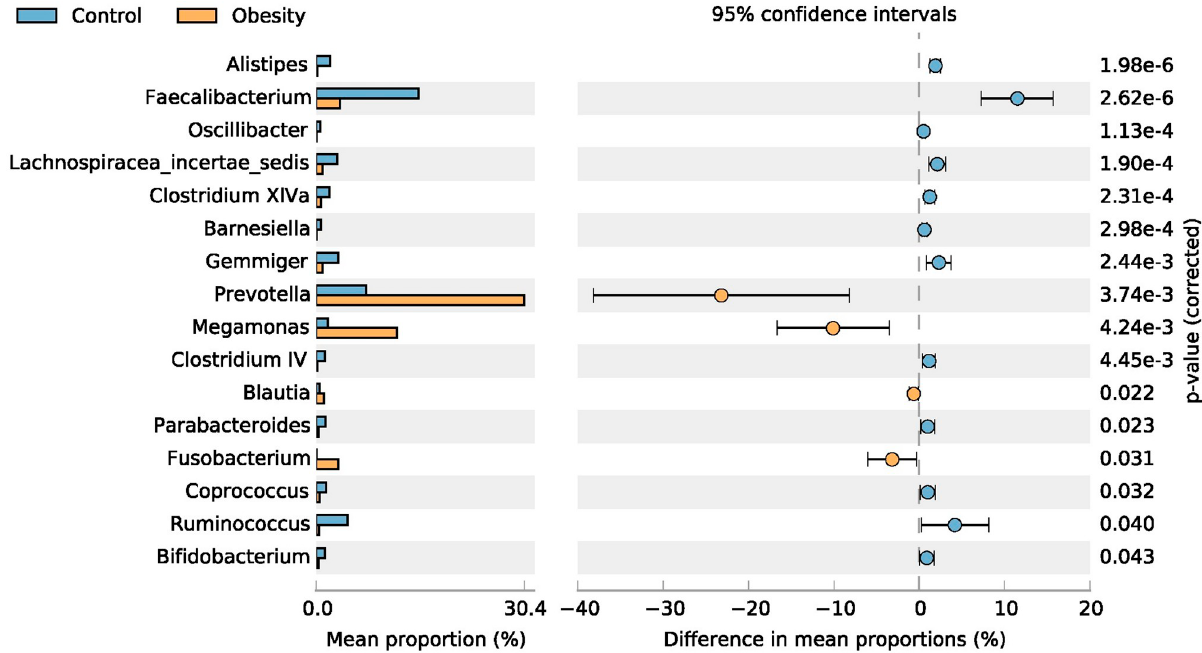
Fig 6. Gut microbiota comparison between obesity and control on the genus level. The genera with significant richness difference ( P < 0.05, computed by STAMP) between the two groups were shown.